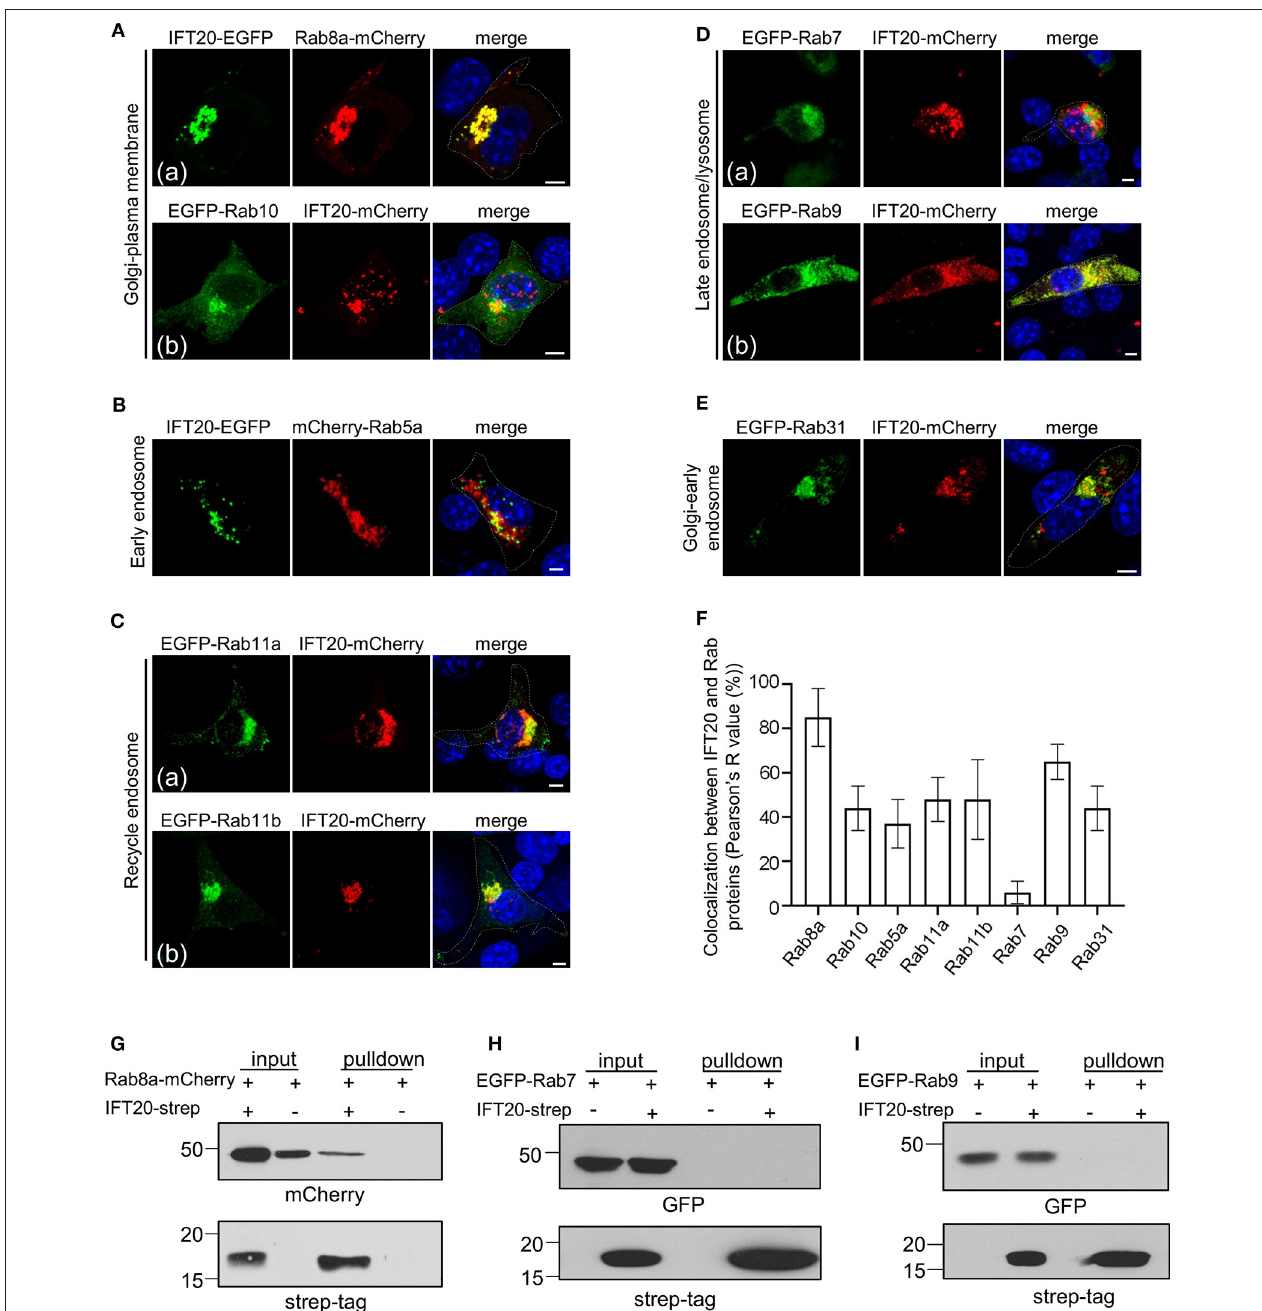
FIGURE 5 | IFT20 mediates the vesicle transport from the TGN to the plasma membrane. (A) Fluorescent images of 4T1 cells co-expressing the Golgi-to-plasma membrane Rab markers Rab8a-mCherry (a) or EGFP-Rab10 (b) with IFT20-EGFP/mCherry. (B) The localization pattern of the early endosome Rab marker mCherry-Rab5a with IFT20-EGFP in 4T1 cells. (C) Representative fluorescent images of 4T1 cells co-expressing the recycle endosome Rab markers EGFP-Rab11a (a) and EGFP-Rab11b (b) with IFT20-mCherry. (D) The localization of the late endosome-associated Rab markers EGFP-Rab7 (a) or EGFP-Rab9 (b) with IFT20-mCherry in 4T1 cells. (E) Fluorescent images of 4T1 cells co-expressing the Golgi-to-early endosome Rab marker EGFP-Rab31 with IFT20-mCherry. (F) The localization quantification (Pearson’s R value) of IFT20 and Rab proteins in (A–E) . Data are recorded in Supplementary Table 2 and represented as the mean ± SD with three different optical sections on 21 cells co-expressing fluorescent proteins in three independent experiments. (G–I) Strep-pulldown assay of IFT20-Strep and Rab8a-mCherry (G) , EGFP-Rab7 (H) , or EGFP-Rab9 (I) . HEK293T cells were transfected with plasmids that express Rab8a-mCherry (G) , EGFP-Rab7 (H) , or EGFP-Rab9 (I) combined with or without IFT20-Strep expression plasmid. After 24h, the cells were lysed and centrifuged. The supernatants (input) were incubated with Strep-Tactin beads, and the proteins bound to the beads (pulldown) were analyzed by Western blot using anti-Strep tag or anti-mCherry/EGFP antibodies. The white dotted lines mark the entire cell profile. The nucleus is stained by DAPI (blue). Scale bar, 5 µ m.